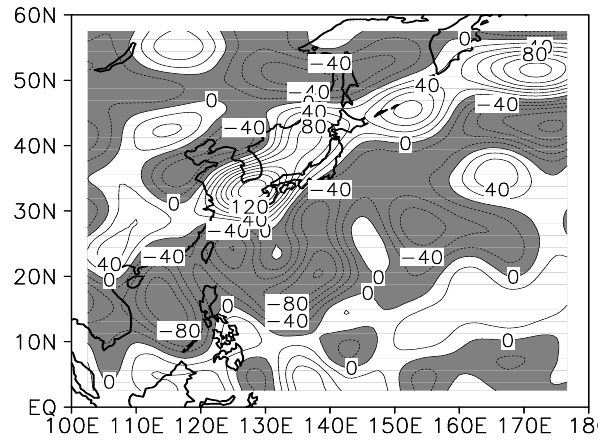
Figure 8. Same as in Figure 4, but for 850 hPa relative vorticity. Contour interval is 20 × 10 −6 s −1 . Shaded areas denote negative values.